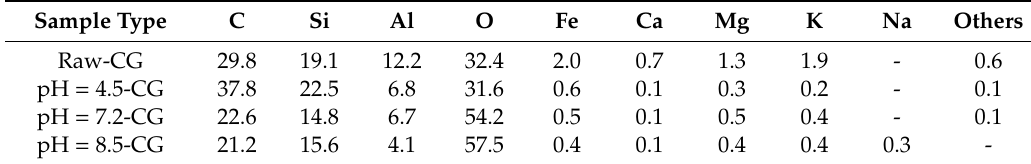
Table 7. Average of the content of each element in the area measured /